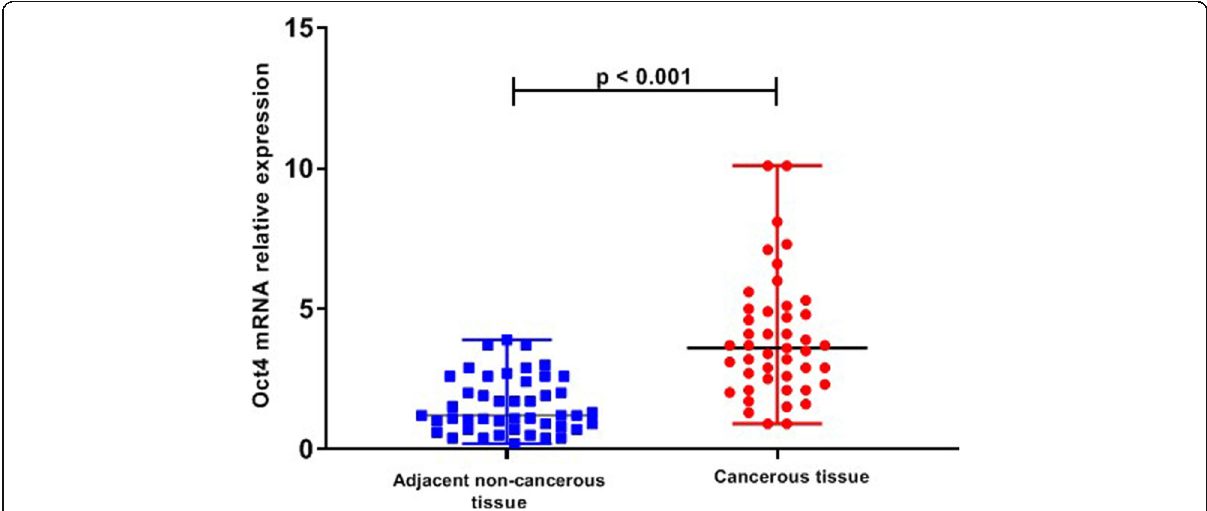
Fig. 2 Oct4 mRNA relative expression in gastric carcinoma and adjacent non-cancerous